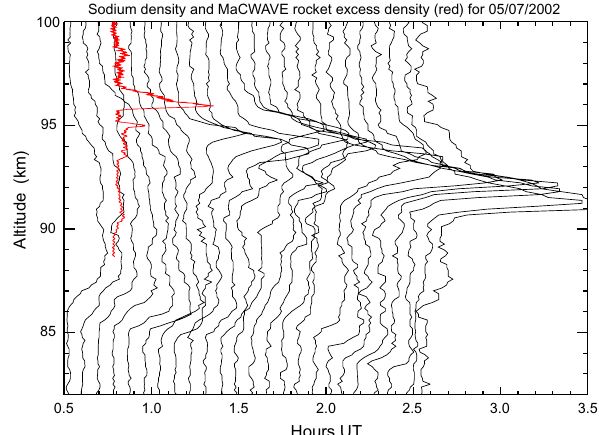
Fig. 4. Sodium lidar observation of the development of a descend- ing sudden sodium layer shortly after the launch of the instrumented rocket. The excess electron density observed by the rocket during the traversal of the sporadic-E layer is shown in red. One hour cor- responds to 5000Na/cm 3 and 10 5 electrons/cm 3